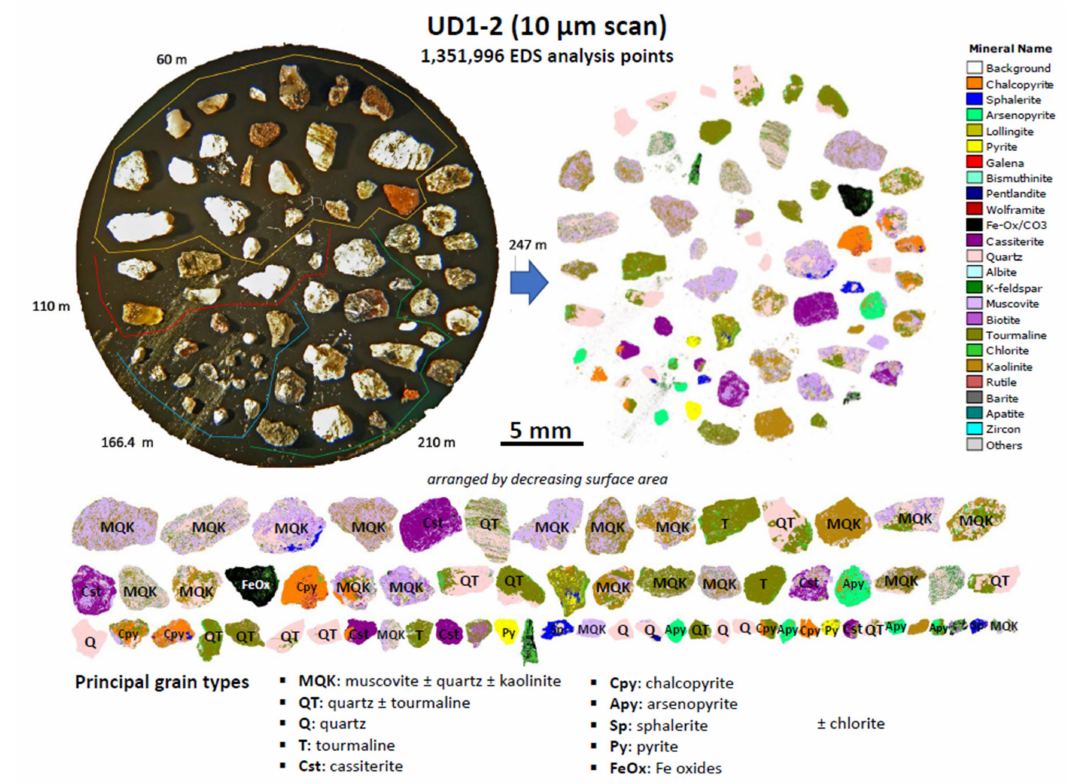
Figure 8. QEMSCAN analysis from the top 210 m of UD-1, accredited to CSM (Camborne School of